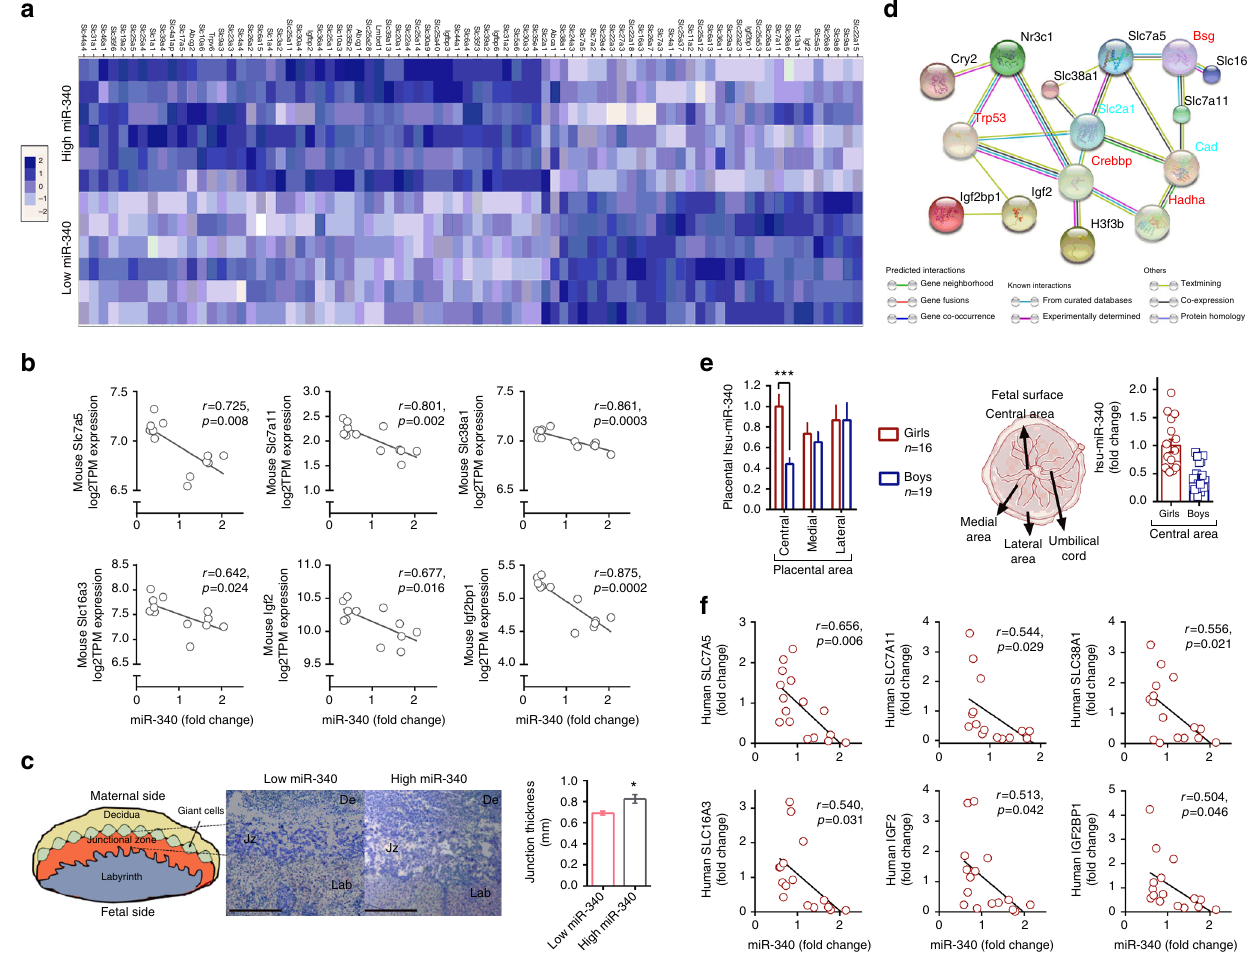
Fig. 4 MiR-340 is associated with differential expression of nutrient transporters both in mouse and human female placenta. a Heat-map comparing placental nutrient transporters between female mice endogenously expressing high or low levels of miR-340. b The expression of Slc7a5, Slc7a11 , Slc38a1 , Slc16a3 , Igf2 , and Igf2bp1 is inversely correlated with miR-340 in mice. c Eosin-hematoxylin staining of the mouse placenta show a thicker junctional zone in the high miR-340 group ( t (6) = 3.07, p = 0.022). d STRING pathway analysis linking the miR-340 targets Nr3c1 , Cry2 , and H3f3b with selected nutrient transporters (https://string-db.org). e Expression of miR-340 in the human placenta in central, medial, and lateral areas. Girls present higher levels in the central area compared to boys (two-way ANOVA F (1,104) = 14.78, p < 0.0001). Data are presented as mean and s.e.m. f The expression of SLC7A5 , SLC7A11 , SLC38A1 , SLC16A3 , IGF2 , and IGF2BP1 are inversely correlated with miR-340 expression in the central area of human samples. Scale bar: 1